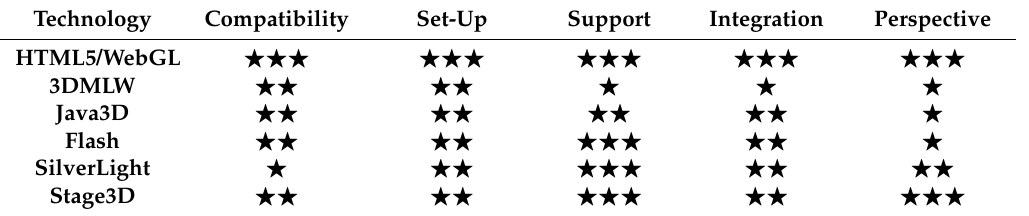
Table 1. Exploratory research summary of Web Graphical Computing technologies (February